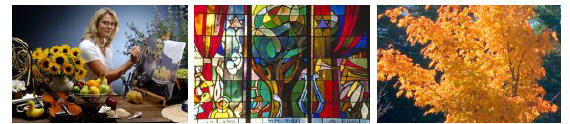
Figure 6 : The ‘Paint Girl’ full scene (left), courtesy of Lexmark. Stained Glass full scene (center), from the Corel database at RIT, Mason Lake, closely-cropped (right), courtesy of Dr. Mark Fairchild